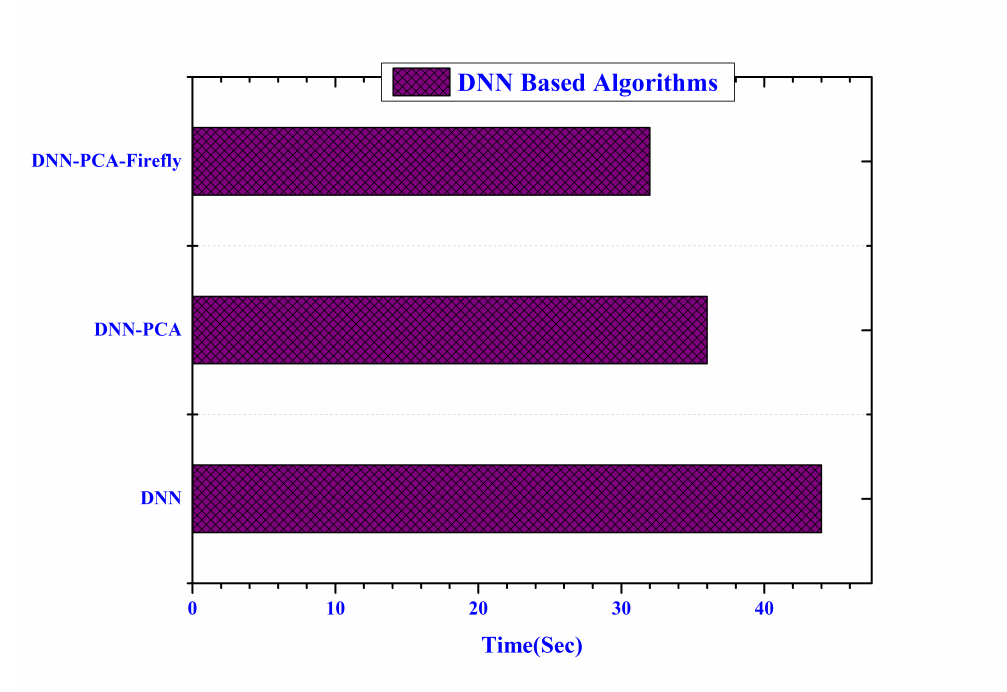
Figure 12. Comparison of Training Time for DNN based